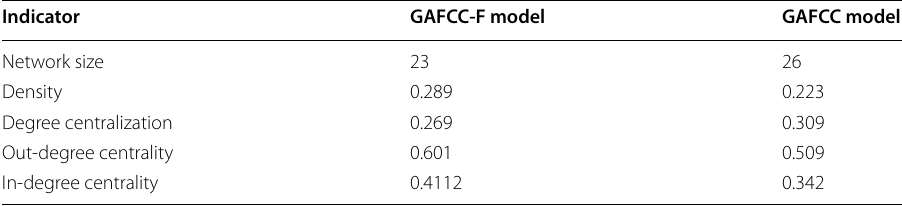
Table 4 Network size, density, and degree centralization and out-degree and in-degree centrality of the GAFCC-F and GAFCC model groups